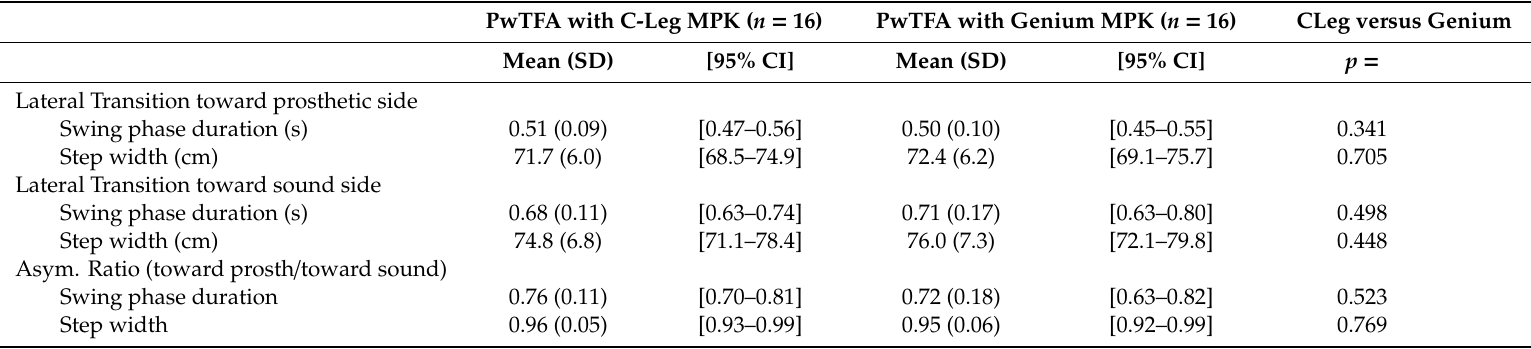
Table 5. Detailed assessments for the iFSST in persons with TFA with the C-Leg or the Genium MPK (decomposition based on prosthetic side and sound